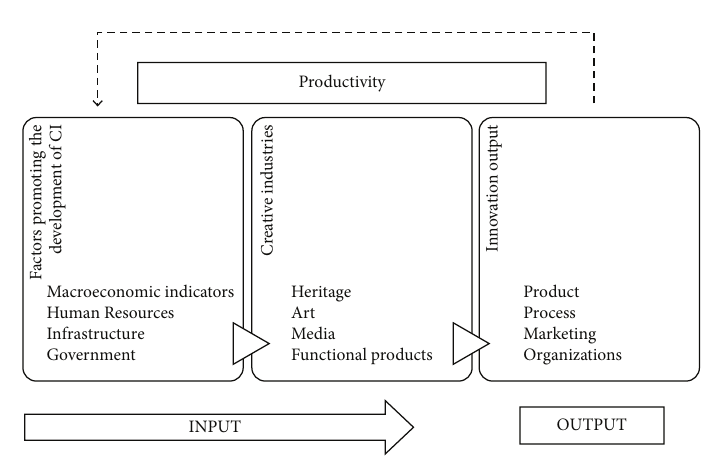
Figure 2. A conceptual model of the relationship between creative industries and innovation (source: created by the authors)